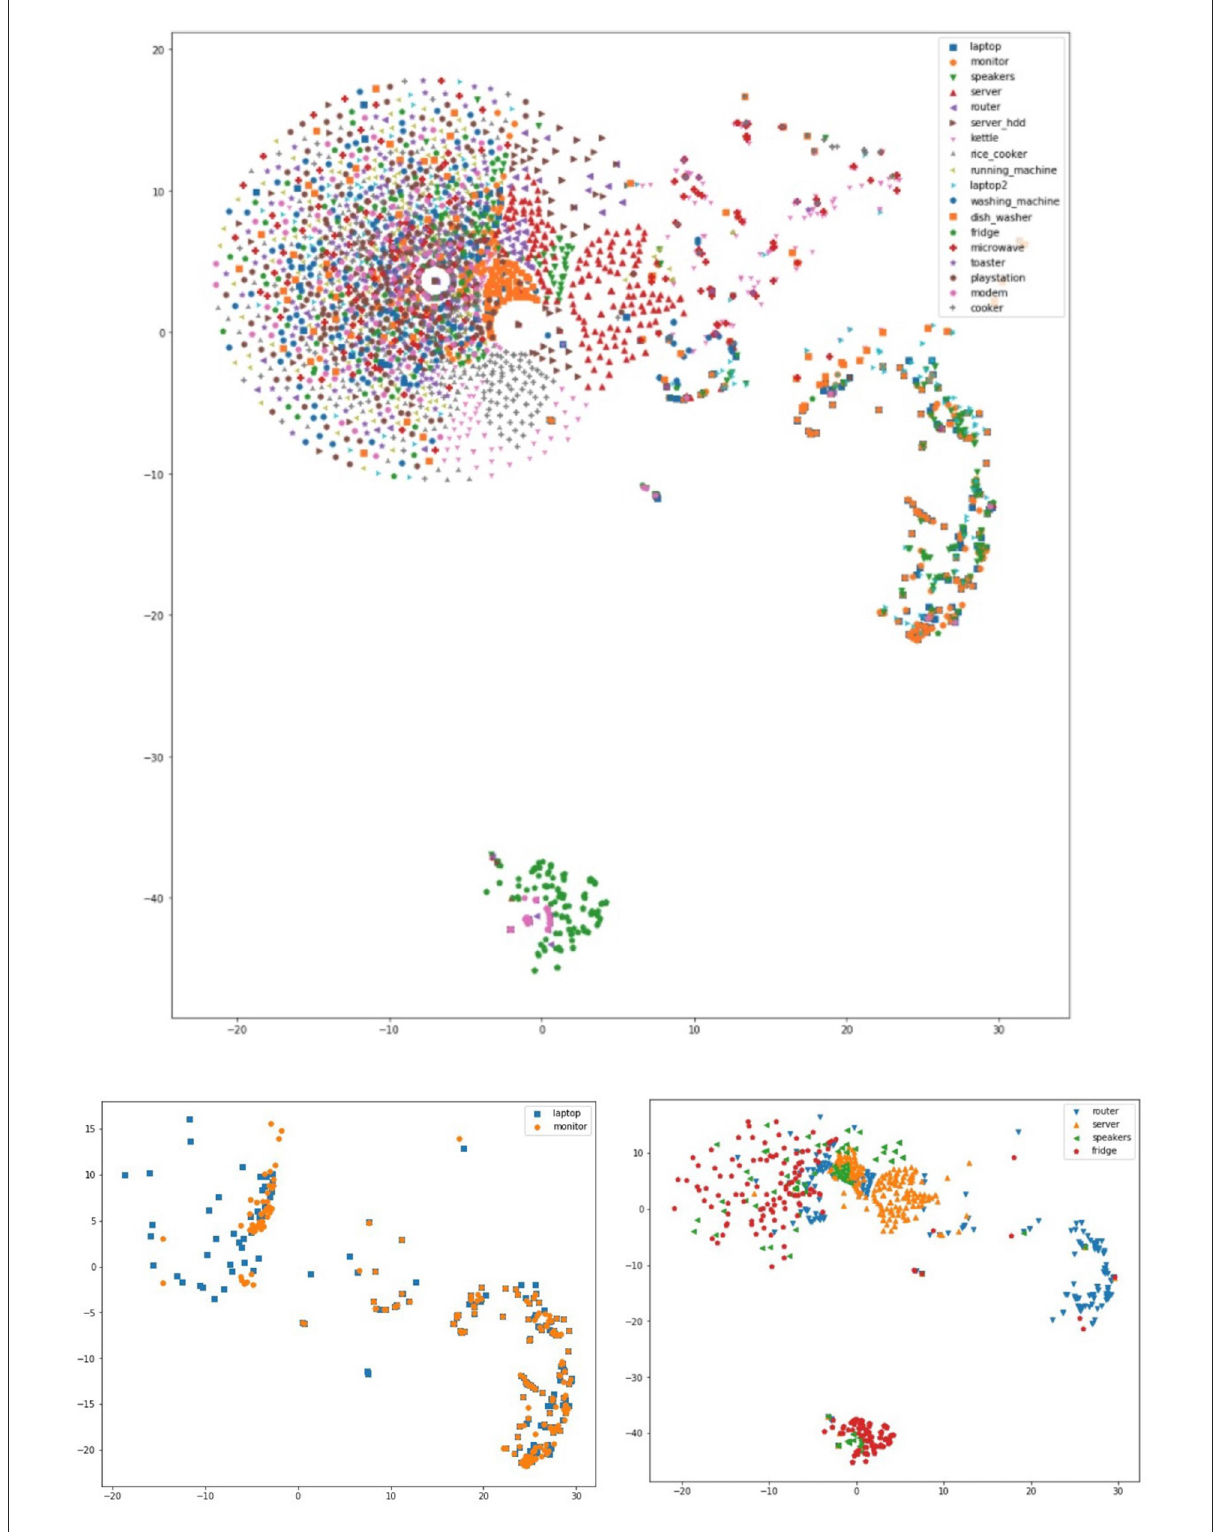
FIGURE10 t-SNE clusters for House 2